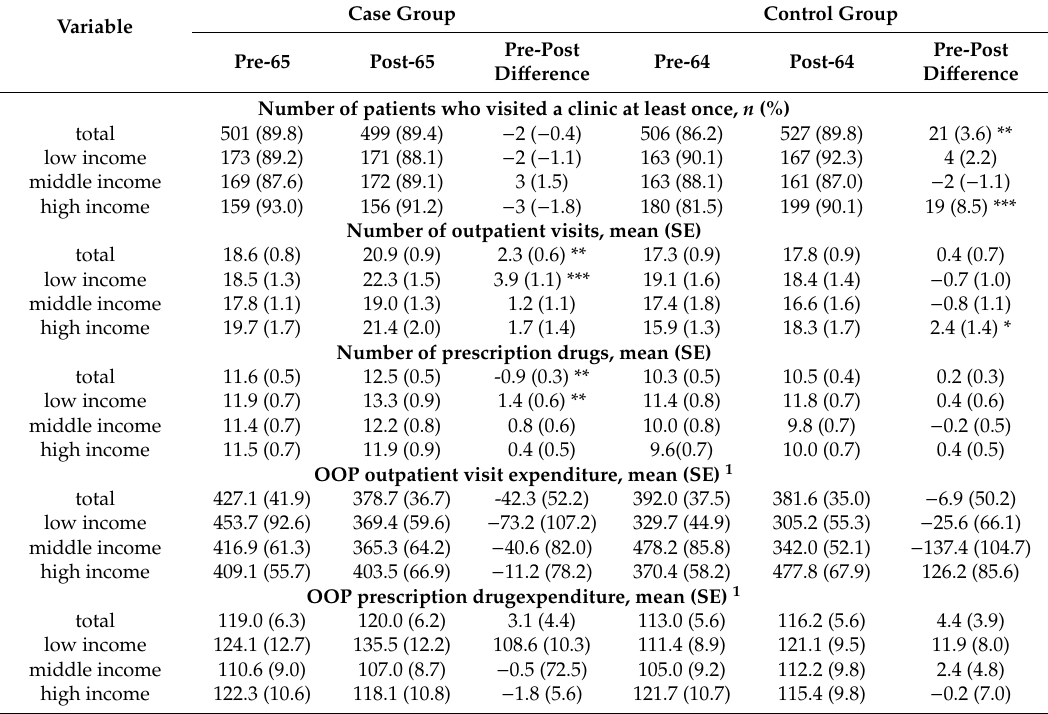
Table 2. Outpatient clinic visit frequency, total prescriptions, and out-of-pocket (OOP) expenditure during one year before and after the cost sharing change by group.